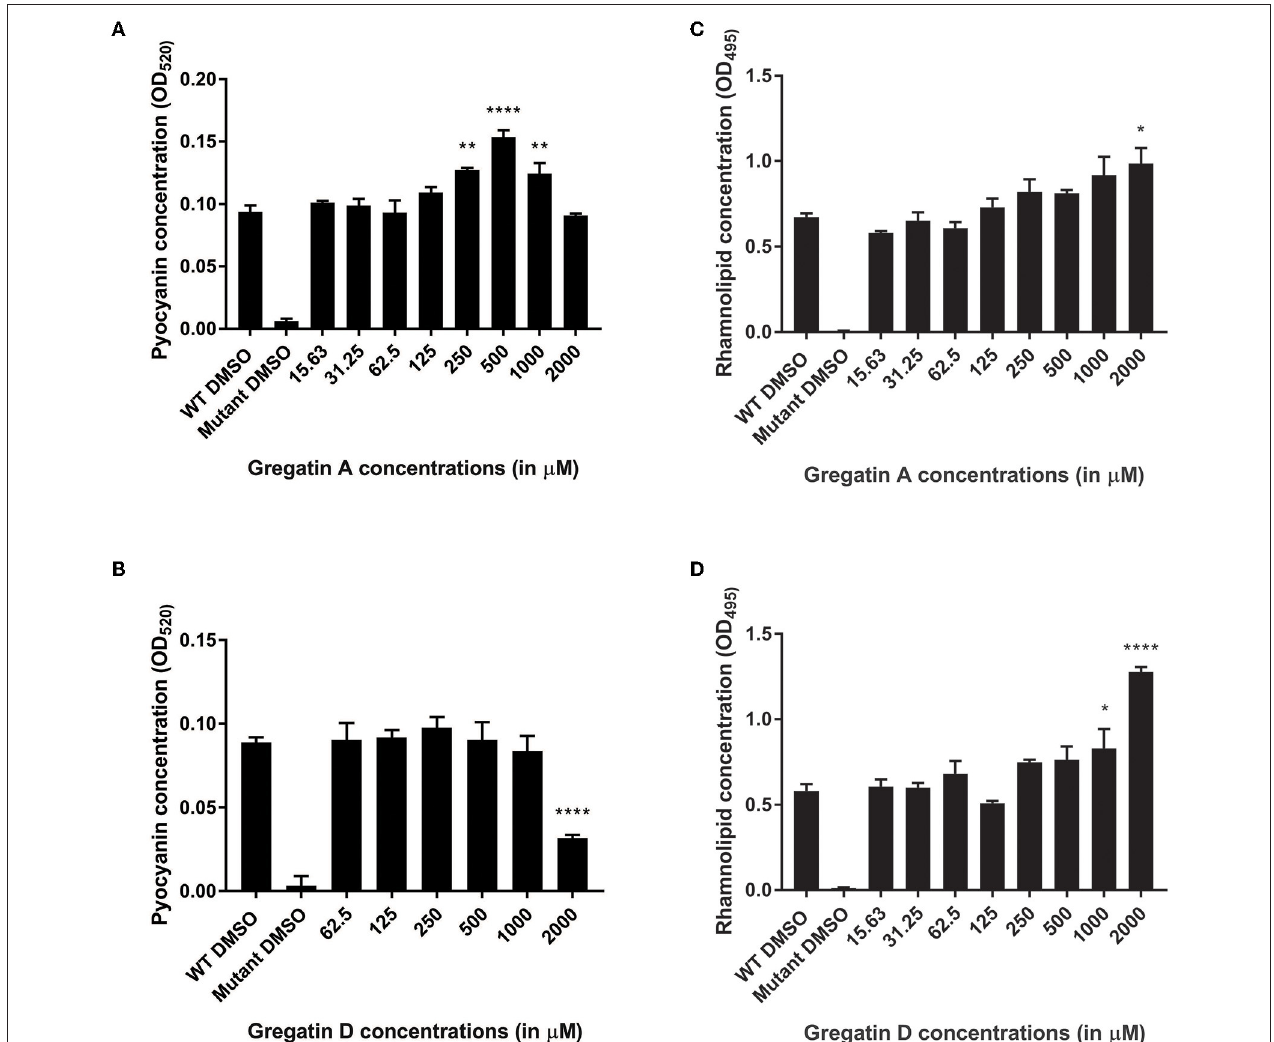
FIGURE 7 | Distinct effects of gregatins on the production of virulence factors. The effect of gregatin A and gregatin D was tested on the production of the virulence factors (A,B) pyocyanin and (C,D) rhamnolipid. The mean of the experiment performed in triplicates was plotted. A one-way ANOVA, corrected for multiple comparisons with Dunnett’s test, was performed to determine statistical significance. Values are compared to DMSO-treated controls (* P < 0.05; ** P < 0.005; **** P <